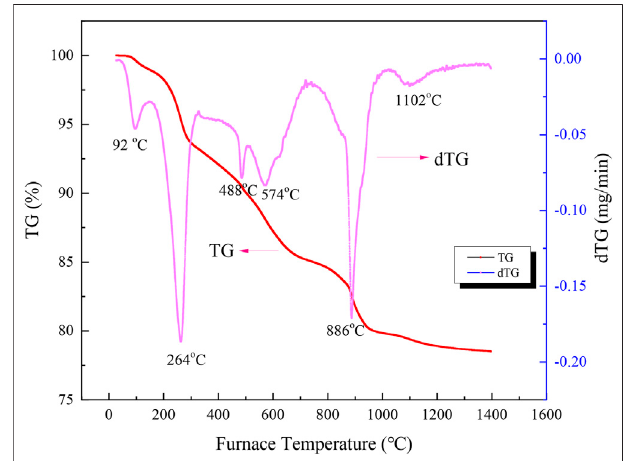
FIGURE 6 | TG-DTG curves of the Na 2 S 2 O 3 /laterite blend.